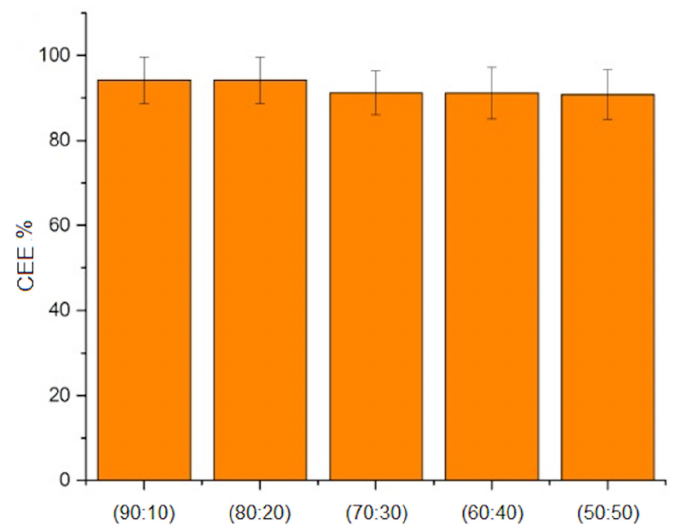
Figure 5. Curcumin entrapment efficiency (CEE) in microspheres at different PHBV/MBGN ratios (error bars show the Standard Deviation).